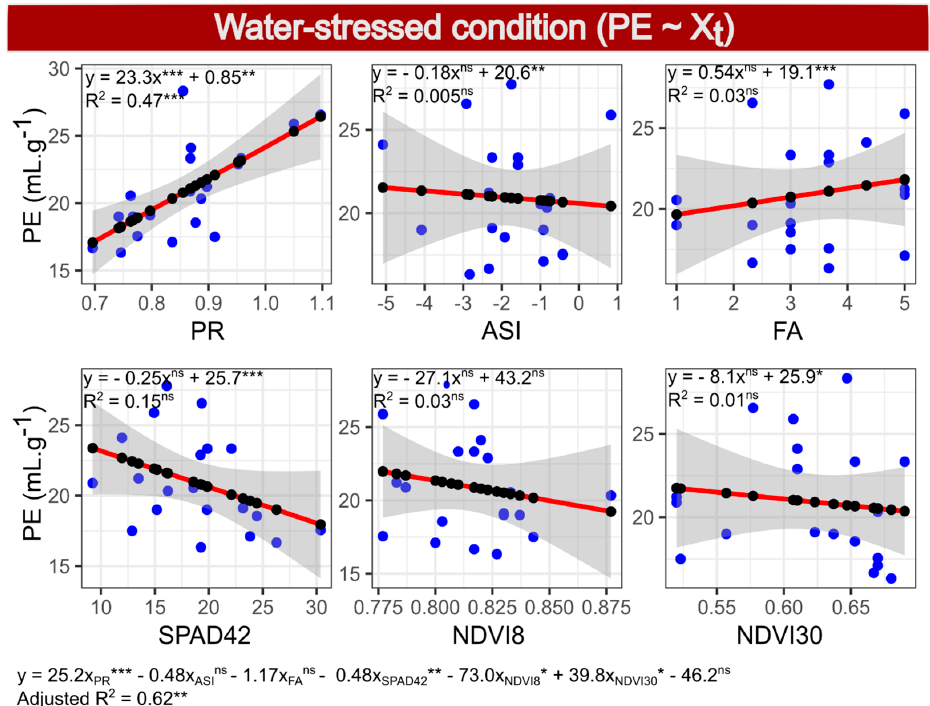
Figure 4. Simple linear regressions (within boxes) and multiple regressions (below three boxes) between the dependent variable popping expansion (PE) and independent variables: prolificacy (PR), anthesis-silking interval (ASI), leaf angle (FA), SPAD index measurement 42 days after anthesis (SPAD42) and normalized difference vegetation indexes evaluated 8 (NDVI8) and 30 (NDVI30) days after anthesis, evaluated in 20 popcorn inbred lines under water stress.